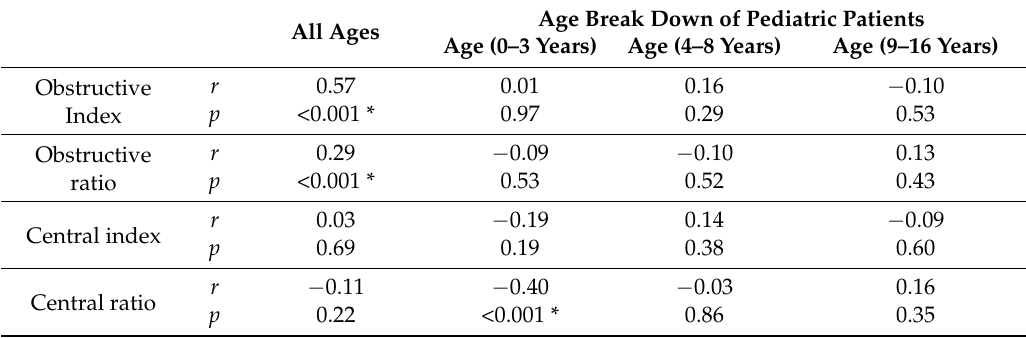
Table 3. Correlation between obstructive/central apnea parameters and